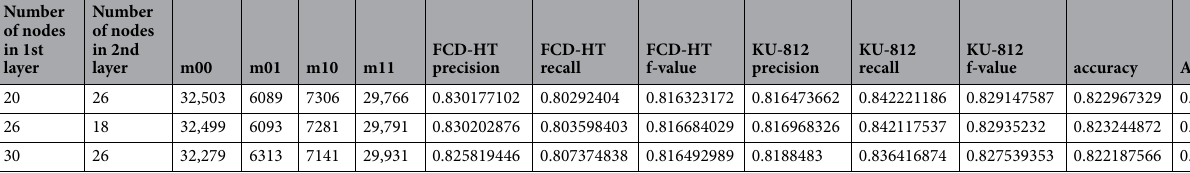
Table 1. Predictive performances of the three candidate learning models using flow cytometry-derived data.